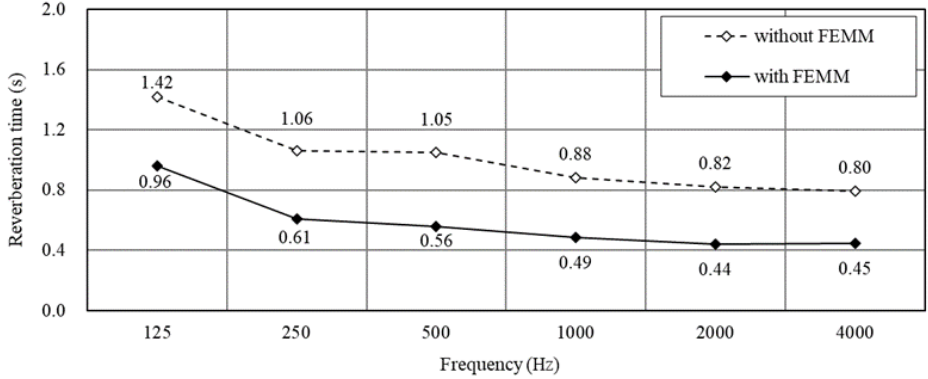
Figure 19. Comparison of the RT at each band.